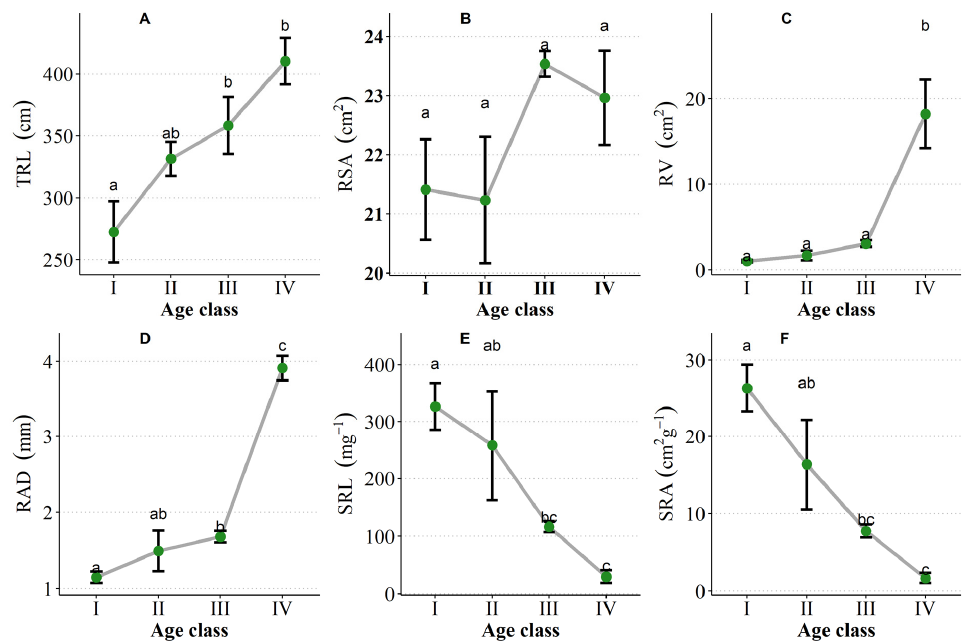
Figure 6. Changes of root traits with the increase of seedling age of Quercus acutissima . ( A ) TRL, total root length; ( B ) RSA, root total surface area; ( C ) RV, root volume; ( D ) RAD, root average diameter; ( E ) SRL, specific root length; ( F ) SRA, specific root area. Different letters above error bars show significant differences.